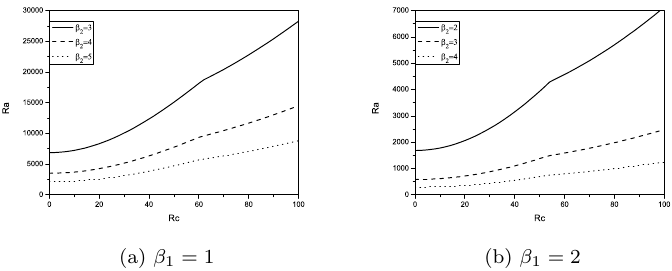
Figure 3. Visual representation of linear instability thresholds, with critical Rayleigh number plotted against the solute Rayleigh number R c .